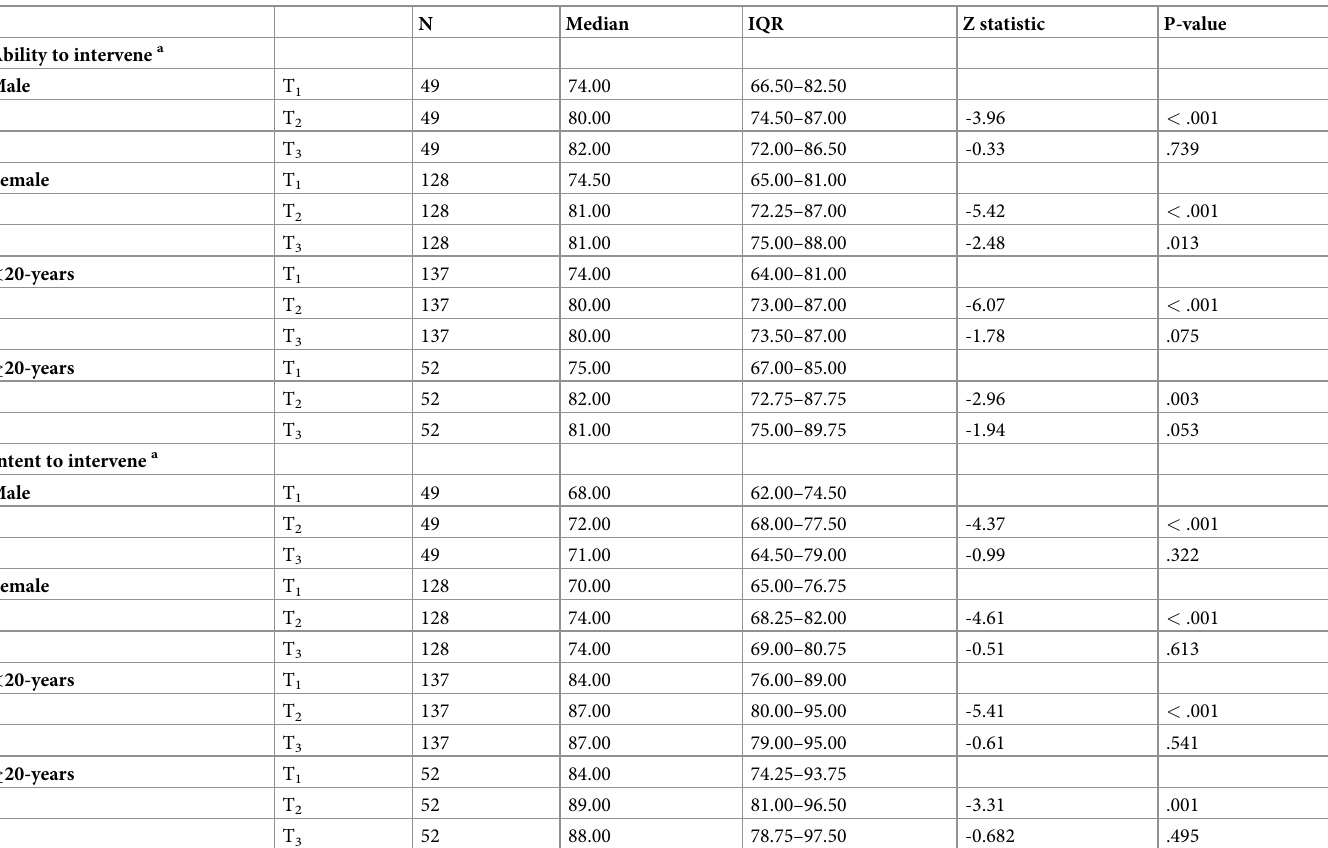
Table 5. Sub-group analyses for ability and willingness to intervene against suicide